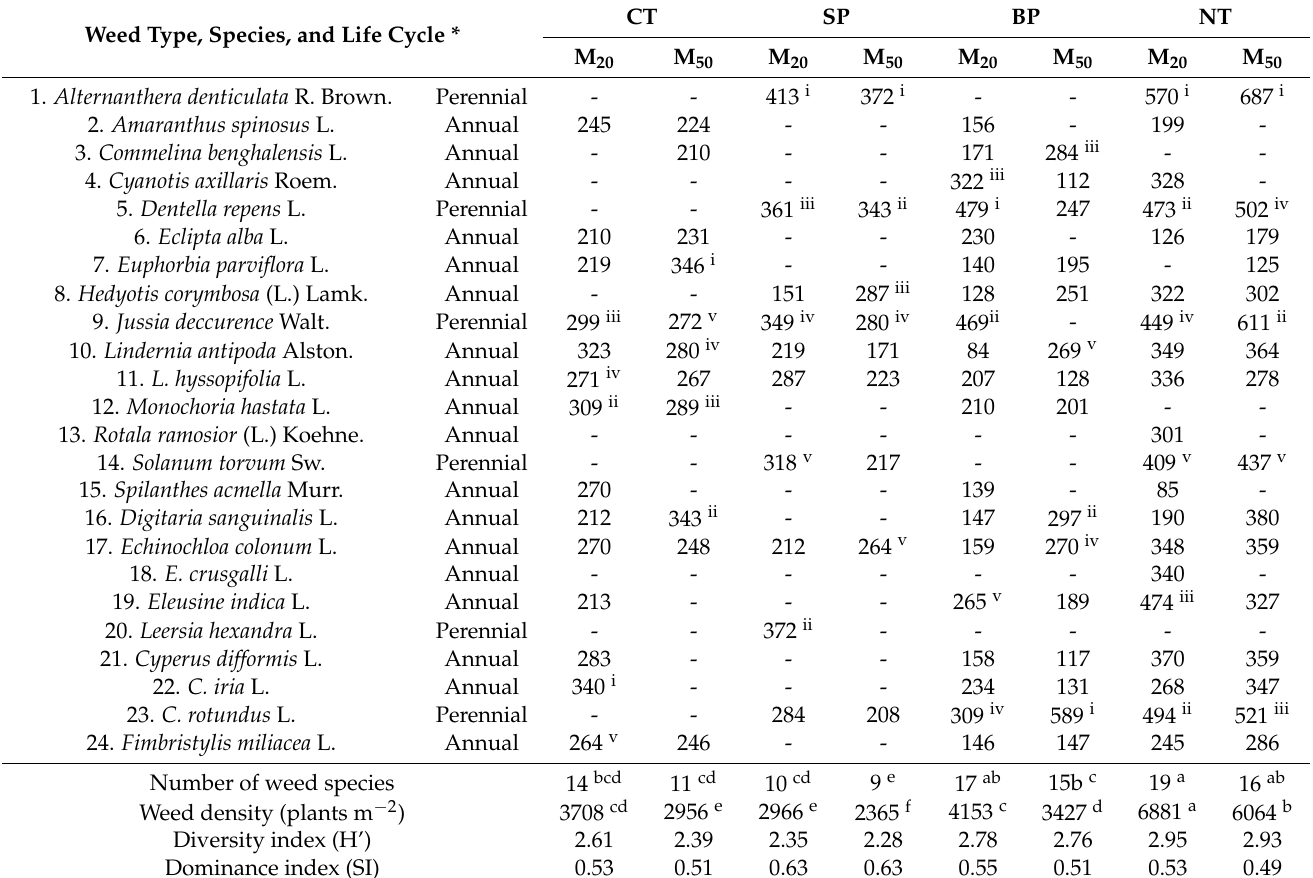
Table 1. Seedbank composition and weed density (plants m –2 ) as affected by tillage and residue mulch treatments in Beluapara after 3